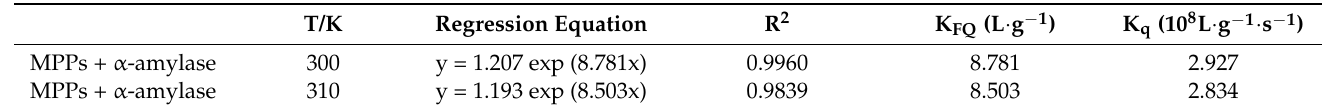
Table 4. The Stern-Volmer regression equations for the fluorescence quenching of α -amylase by MPPs at different